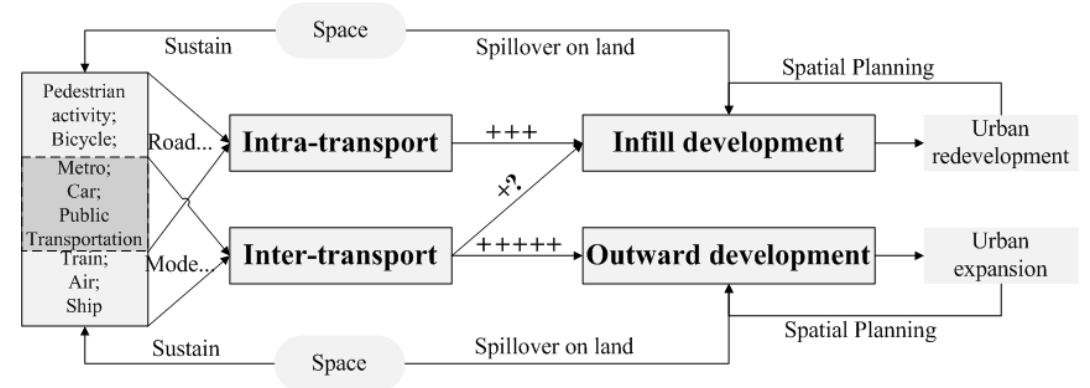
Figure 1. Regional transportation development and land use.